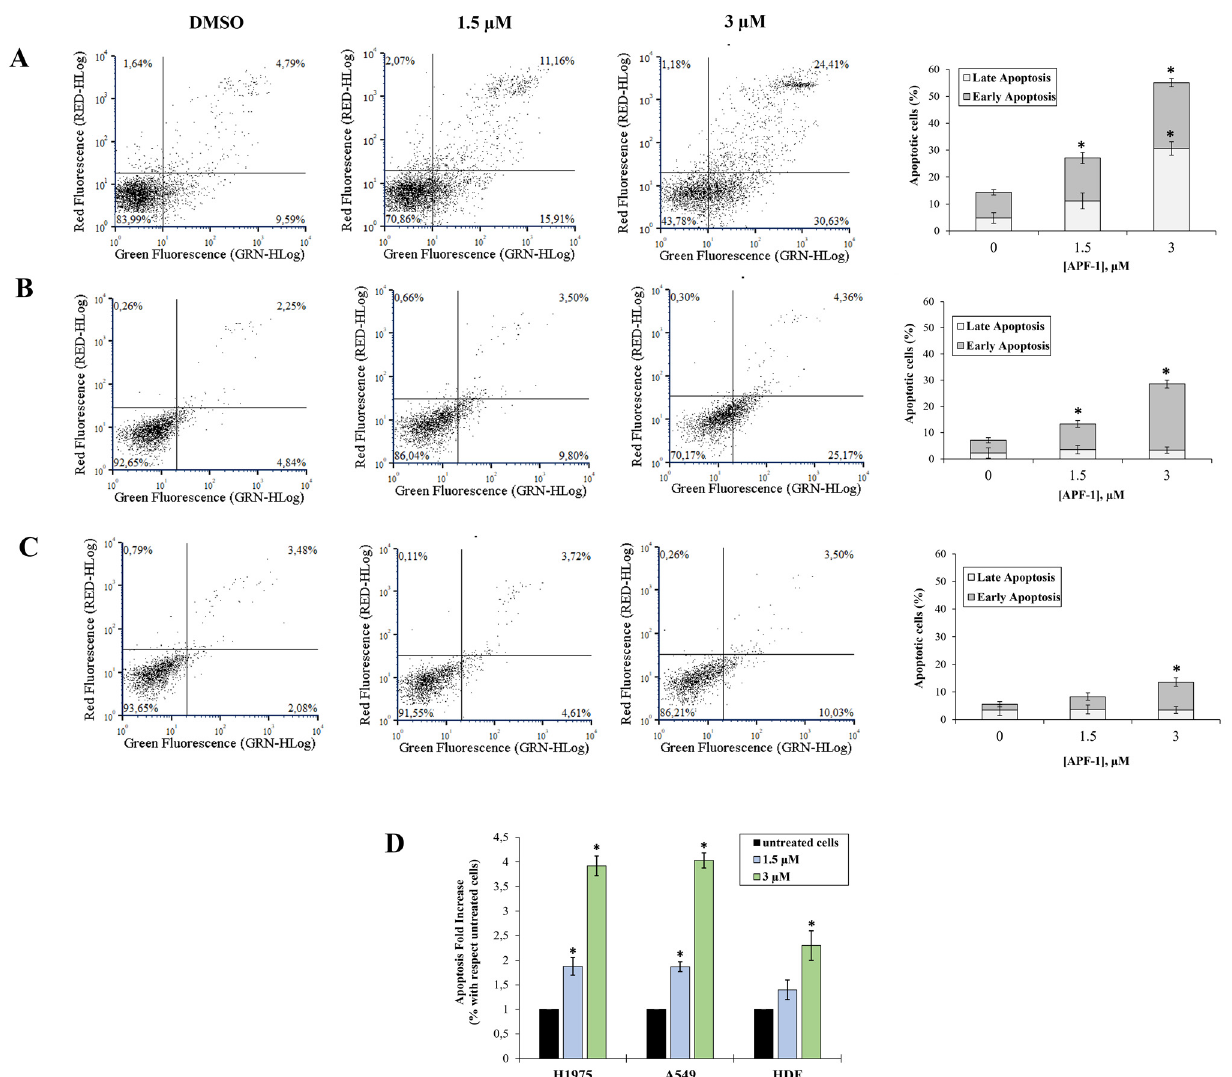
Figure 3. The effect of APF-1 on apoptosis level in NSCLC and HDF cell. Flow cytometry analysis of ( A ) H1975, ( B ) A549, and ( C ) HDF cells after 24 h with different APF-1 treatments (1.5 and 3 µM) using Annexin V/FITC and PI double stain. GRN-HLog refers to the green fluorescence intensity (FITC channel) and RED-HLog to the red fluorescence intensity (PI channel). On the left there are representative cytograms obtained after flow cytometry analyses by using Annexin V/FITC and PI double stain: viable (Annexin V − PI − ), early apoptotic (Annexin V+PI − ), late apoptotic (Annexin V+PI+), and necrotic (Annexin V − PI+) cells. The histograms on the right represent the percentages of early and late apoptosis. ( D ) Apoptosis quantified as a fold increase with respect to the control (non-treated cells). The data are the mean of triplicated experiments ± standard deviation. Significant differences with respect to untreated cells are indicated with * p < 0.05.